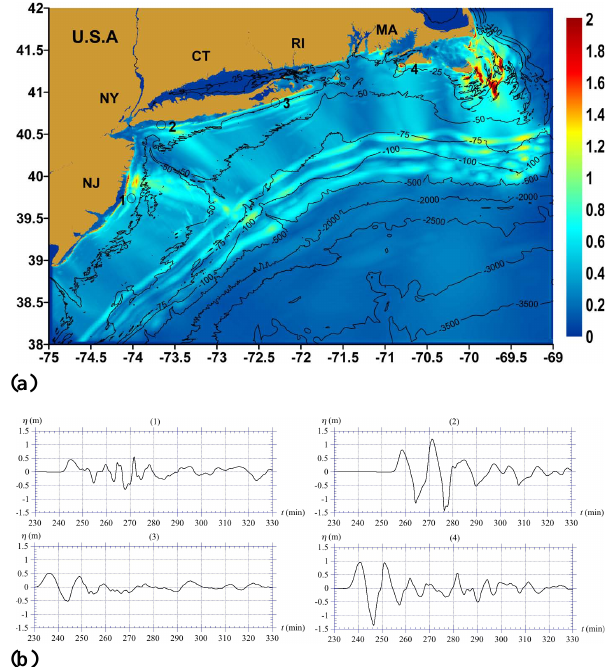
Fig. 4. (a) Bathymetry (black isobaths marked in meters; USGS 100m resolution) for New Jersey, Long Island, Rhode Island and Cape Cod areas, and nearshore tsunami simulations for 9.1PRT co- seismic source of Fig. 2a, in nested 15 00 regional grid (450m; ini- tialized with Fig. 3 results): (a) maximum surface elevation at any time during computations (color scale in meter; axes are in degrees of N Lat. and W Long.); (b) time series of tsunami arrival at lo- cations 1-4 (numerical gages) marked as symbols ( ◦ ) in (a), with depth 14.4, 3.2, 18.1, and 14.8m, respectively , for points (1) to (4); times correspond to the start of the tsunami